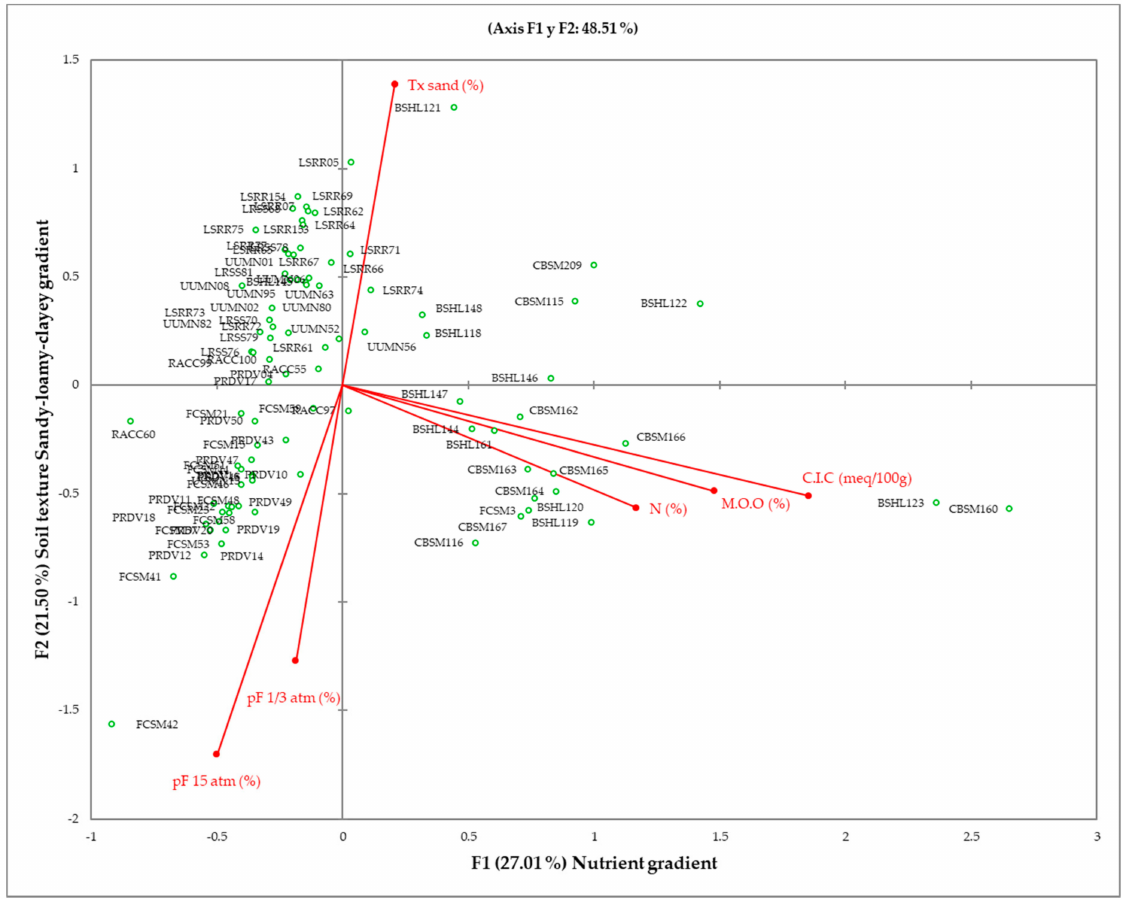
Figure 7. Canonical correspondence analysis. The horizontal axis can be interpreted as a gradient from lowest to highest soil nutrient content (from left to right), while the vertical axis is a gradient of soil texture from loamy-marl to sandy soils (from bottom to top). The red vectors represent the soil variables (C.I.C. = cation interchange complex, M.O.O. = oxidizable organic matter, N = nitrogen, pF 1/3 = water potential at 1/3 atm., pF 15 = water potential at 15 atm. and Tx sand = sandy soil texture); the longer they are, the greater the influence of that variable. The green points represent the sampling points; the closer they are to a vector, the more they are influenced by that particular